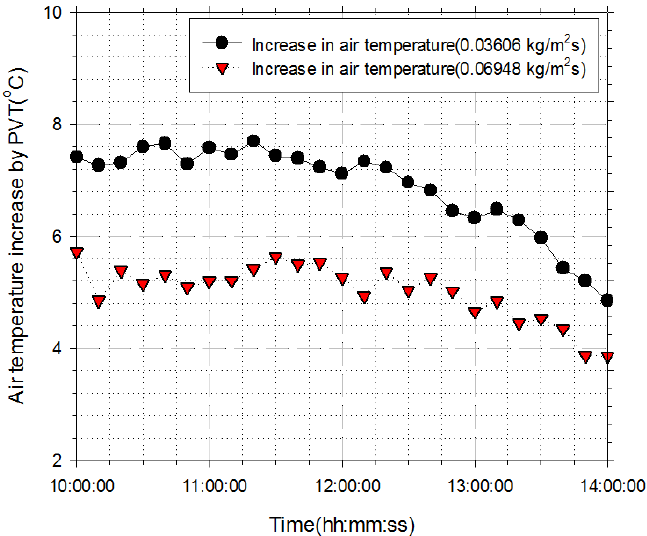
Figure 7. Air temperature increase by PVT air collector with operating time.